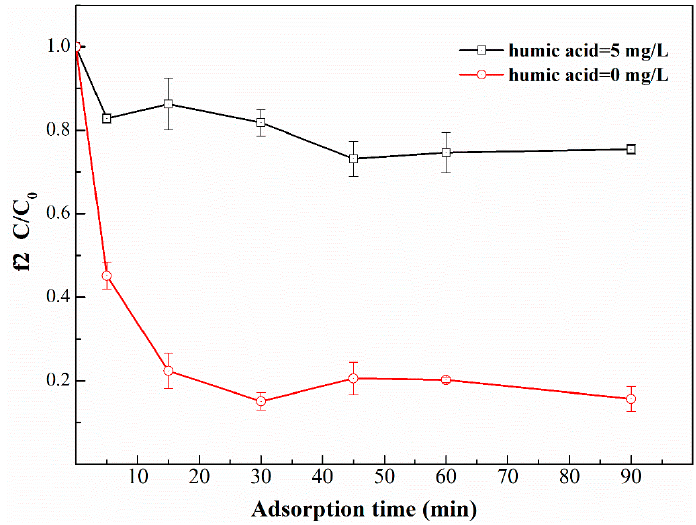
Figure 1. The effect of humic acid on the adsorption of phage f2 by TiO 2 -P25 in the dark.